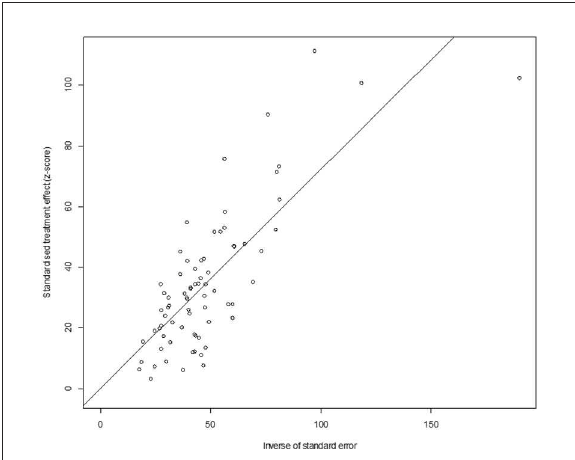
FIGURE6 Egger’s test for publication bias (decetion antibody).